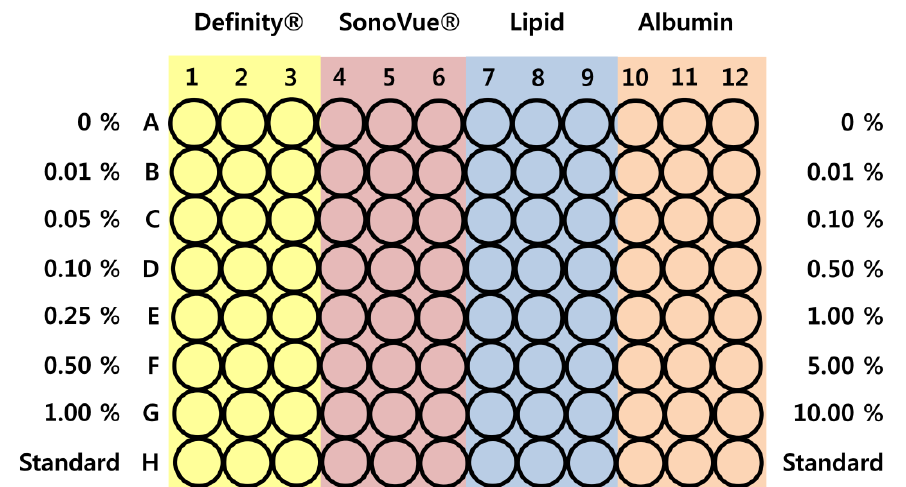
Figure 11. Toxicity evaluation setup. The 293A human embryo kidney cell line was used for toxicity